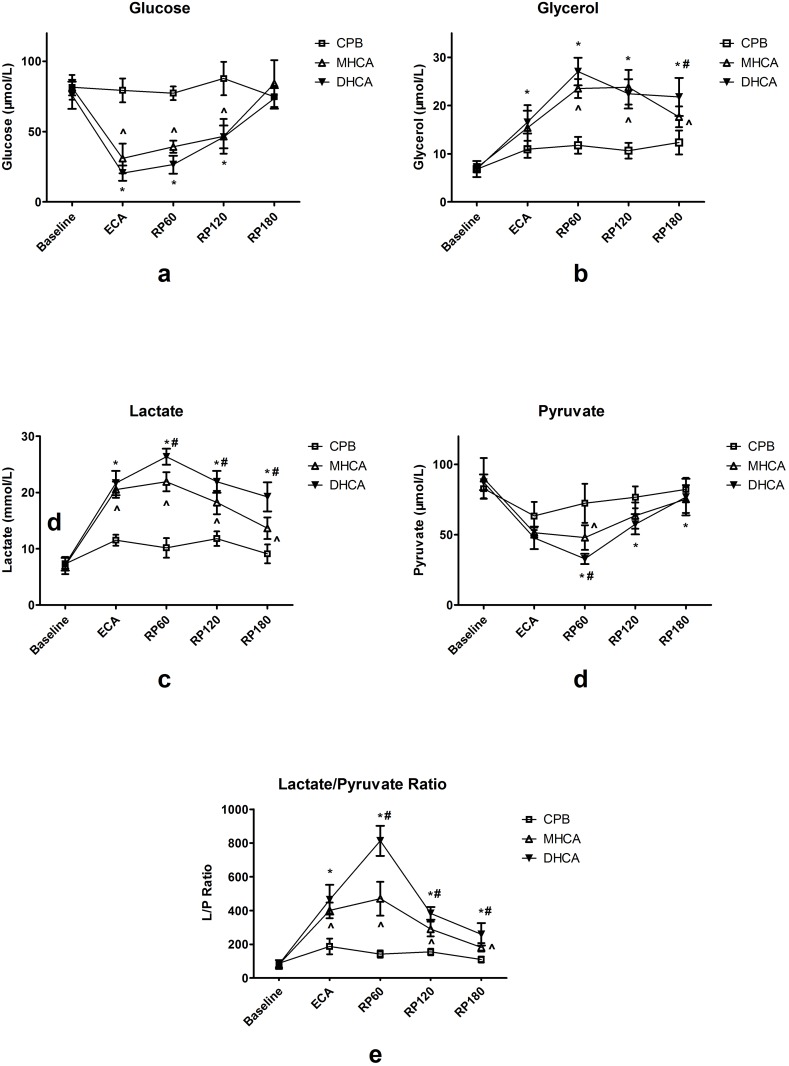
a-e. Microdialysis parameters in interstitial fluid of small intestine. Fig 5a, Glucose; Fig 5b, Glycerol; Fig 5c, Lactate; Fig 5d, Pyruvate; Fig 6e, Lactate/ Pyruvate ratio. CPB, cardiopulmonary bypass group; DHCA, deep hypothermic circulatory arrest group; MHCA, moderate hypothermic circulatory arrest group. ^ P<0.05 MHCA vs CPB; * P<0.05 DHCA vs CPB; # P<0.05 DHCA vs MHCA. ECA, end of cardiac arrest; RP60, reperfusion for 60min; RP120, reperfusion for 120min; RP180, reperfusion for 180min.